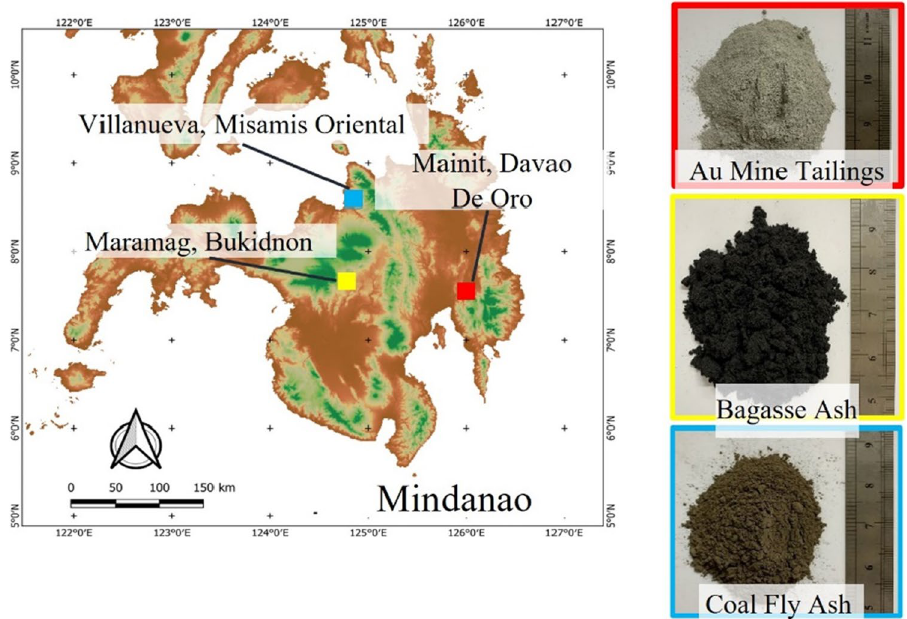
Figure 1. Map of Mindanao and the locations of the impounding facilities (source: QGIS 3.22.12, (https:// www. qgis. org/ en/ site/ index. html); and the as-collected raw samples.